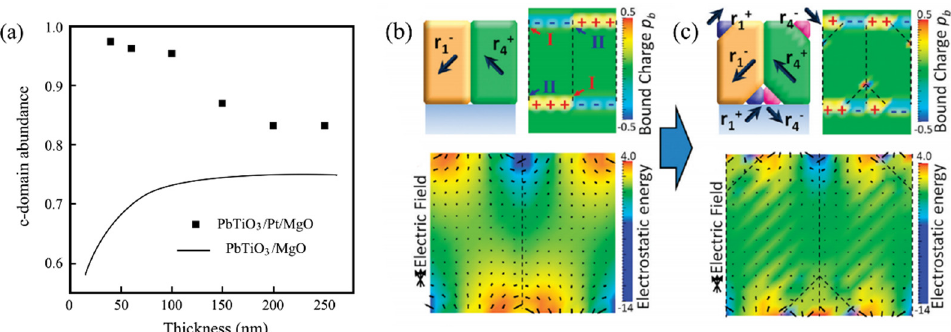
Figure 11. ( a ) C-domain fraction in PbTiO3 films deposited on the MgO substrate with and without Pt electrode. Reprinted with permission from [132] 2004 AIP Publishing. The fraction of c-domain decreases/increases with increasing film thickness in the presence/absence of Pt electrode. ( b , c ) The formation of 180 ◦ FC domains in ultra-thin BiFeO 3 films could reduce the electrostatic energy. Reprinted with permission from [134] 2011 American Chemical Society. ( b ) The bound charge (up) and electrostatic energy (down) before 180 ◦ domain formation; ( c ) the bound charge (up) and electrostatic energy (down) after 180 ◦ domain formation.